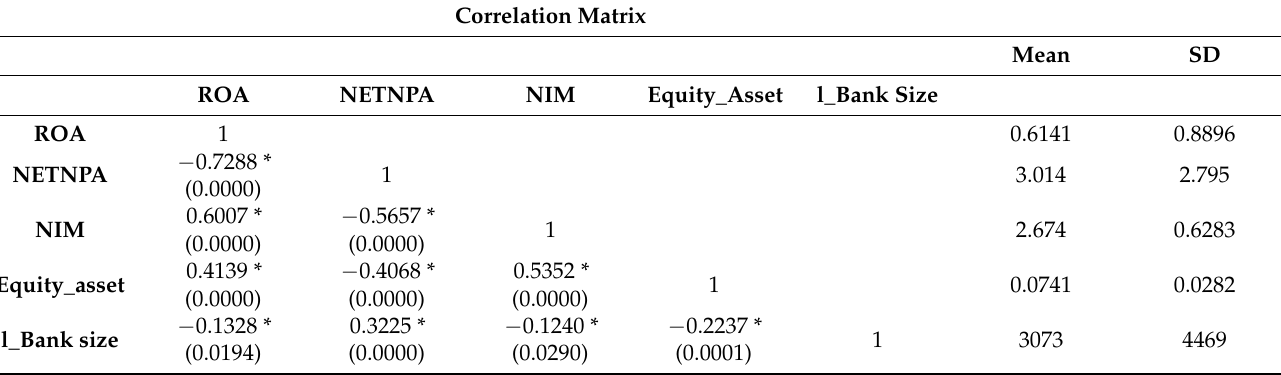
Table 2. Descriptive Statistics and